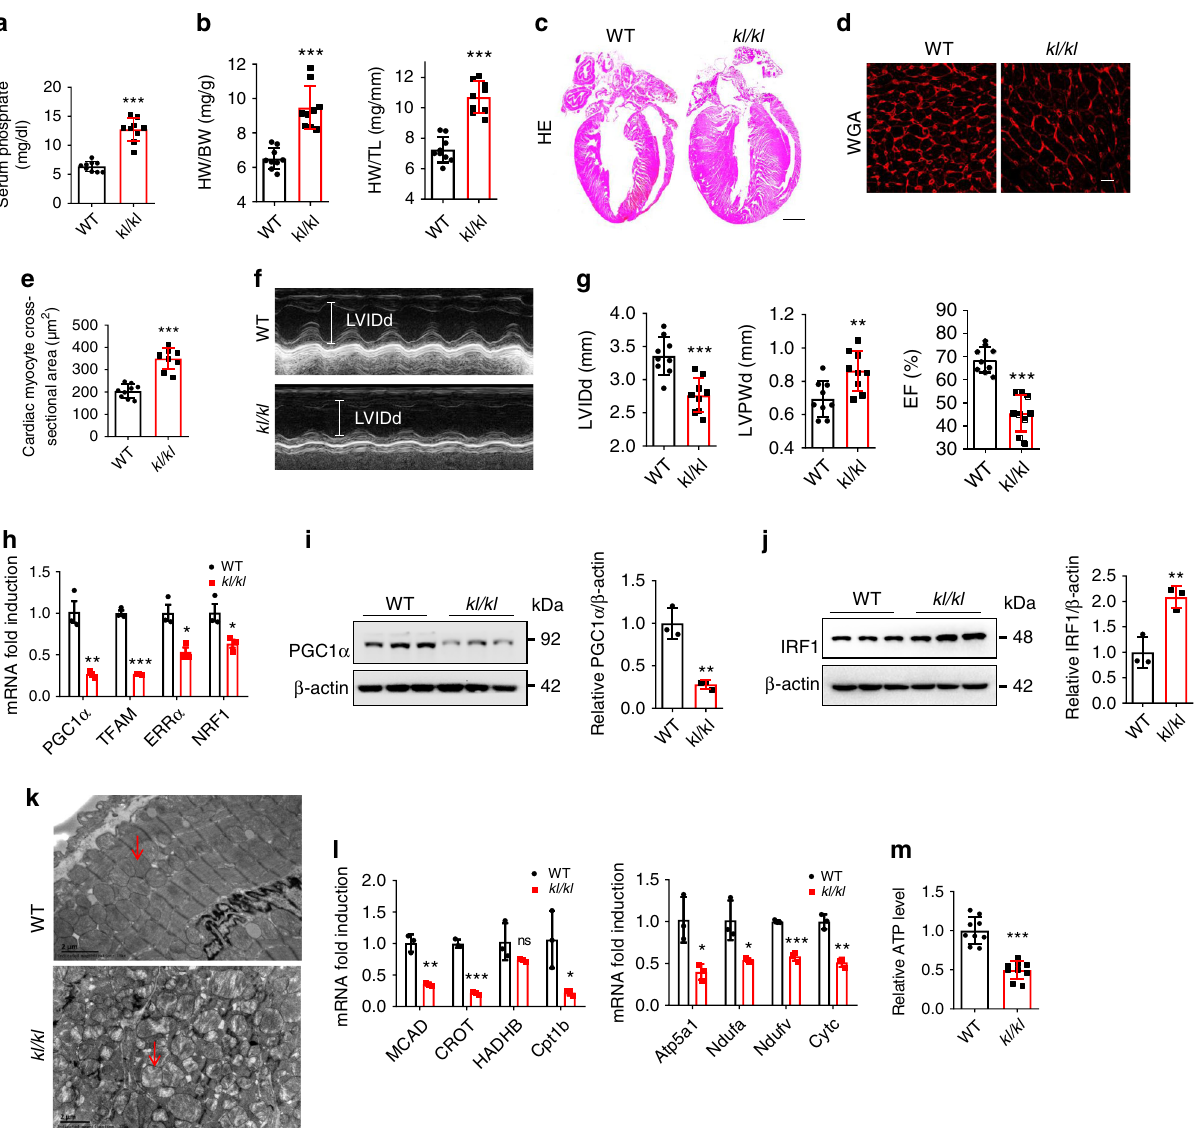
Fig. 7 Klotho de fi ciency leads to hyperphosphatemia, LVH, and heart failure. a Serum phosphate levels of wild type (WT) and kl/kl mice. n = 9 mice per group. b The ratios of heart weight (HW) to body weight (BW), and HW to tibial length (TL) of mice in a . c , d Representative gross pathology ( c HE staining, scale bar, 1 mm) and WGA staining ( d scale bar, 10 μ m) of heart sections from WT and kl/kl mice. e Cross-sectional surface area of individual cardiac myocytes from mice in d . f , g Echocardiography of LVIDd, LVPWd, and EF% in WT and kl/kl mice. h – k qPCR analysis of PGC1 α and its target genes ( h ), western blot analysis of PGC1 α ( i ), and IRF1 ( j ) expressions, representative images of TEM observation of mitochondria ( k ). Red arrows point to mitochondria. Scale bar, 2 μ m, relative mRNA expression of metabolic genes ( l ), and relative ATP level m in the heart samples from WT and kl/kl mice. n = 9 ( a , b , e , g , m ), or n = 3 ( h – l ). Data are shown as mean ± SD and were analyzed by a two-tailed unpaired t -test ( a , b , e , g – j , l – m ). * P < 0.05, ** P < 0.01, *** P <